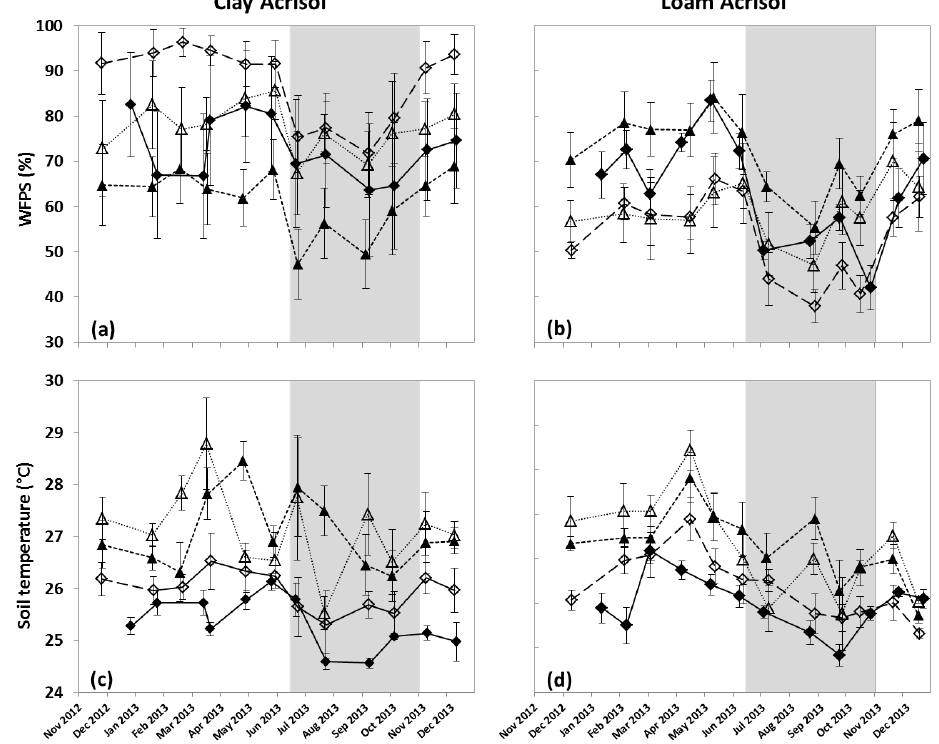
Figure 1. Mean ( ± SE, n = 4) soil water-filled pore space (WFPS) and soil temperature in the top 0.05m depth under forest ( (cid:7) ), jungle rubber ( ♦ ), rubber ( (cid:78) ) and oil palm ( (cid:77) ) in the clay Acrisol soil ( a and c ) and the loam Acrisol soil ( b and d ) in Jambi, Sumatra, Indonesia, measured monthly from December 2012 to December 2013. Grey shadings mark the dry season. Table 1. Mean ( ± SE, n = 4) soil-extractable mineral nitrogen in the top 0.05m depth for different land-use types within each soil landscape in Jambi, Sumatra, Indonesia, measured monthly from December 2012 to December 2013. Means followed by different lowercase letters indicate significant differences among land-use types within a soil landscape and different capital letters indicate significant differences between soil landscapes within a land-use type (linear mixed-effect models with Fisher’s least significant difference (LSD) test at P ≤